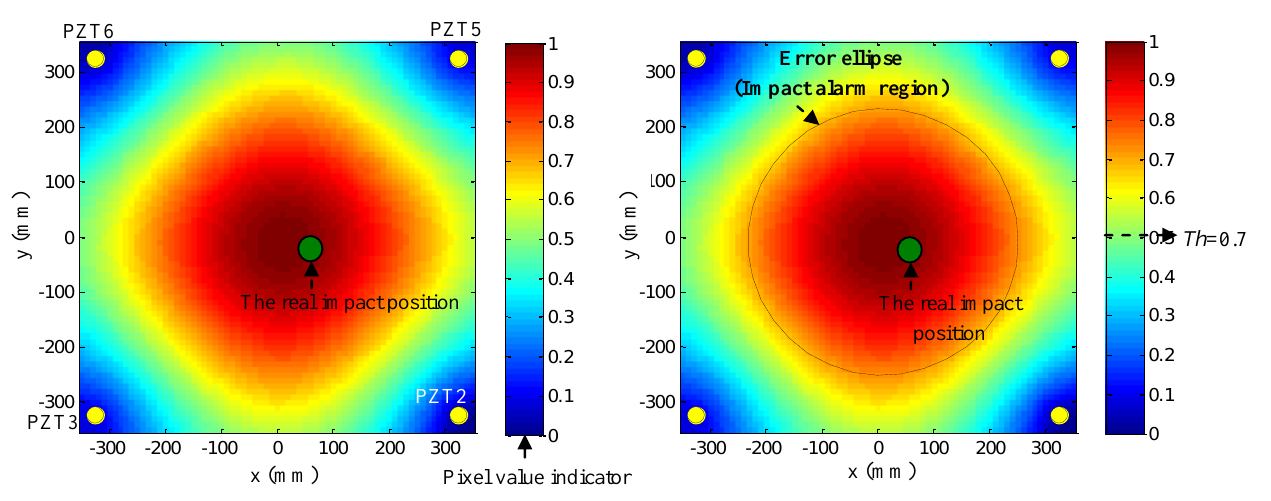
Figure 12. Illustration of impact imaging result and the impact alarm region. ( left ) Impact alarm region imaging result; ( right ) Error ellipse based impact alarm region